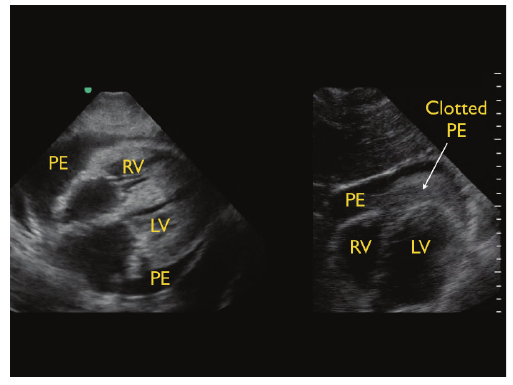
Figure 2: Types of pericardial e ff usions, subxiphoid cardiac view. Left image: typical e ff usion, right image: clotted e ff usion. RV: right ventricle, LV: left ventricle, PE: pericardial e ff